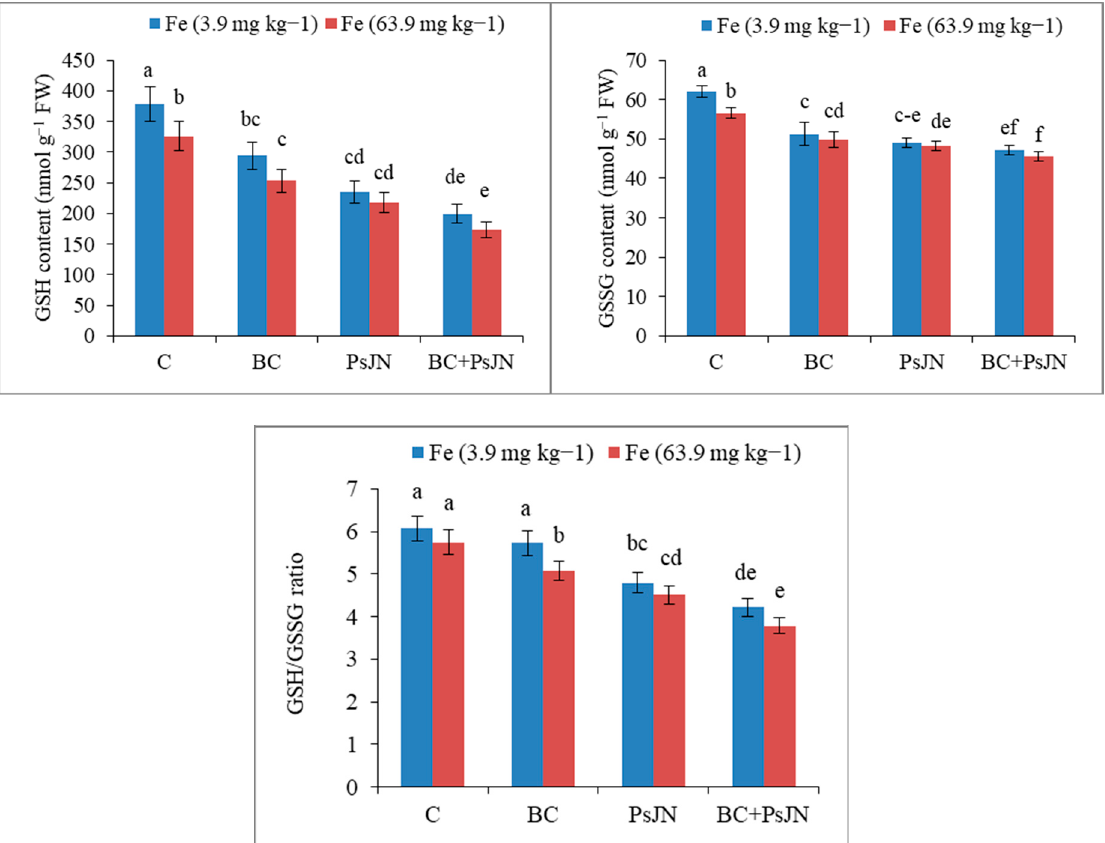
Figure 3. The effect of biochar- Burkholderia phytofirmans PsJN integration on Glutathione homeostasis of Chenopodium quinoa under salinity stress. GSH = Reduced glutathione, GSSG = Oxidized glutathione, GSH/GSS ratio. Quantities sharing similar letters are not different with each other. C: Control; BC: Biochar (1% w / w ); PsJN: Burkholderia phytofirmans ; Fe: Ferrous sulphate (15 kg ha − 1 ). Values are mean of three repeats ± SD.